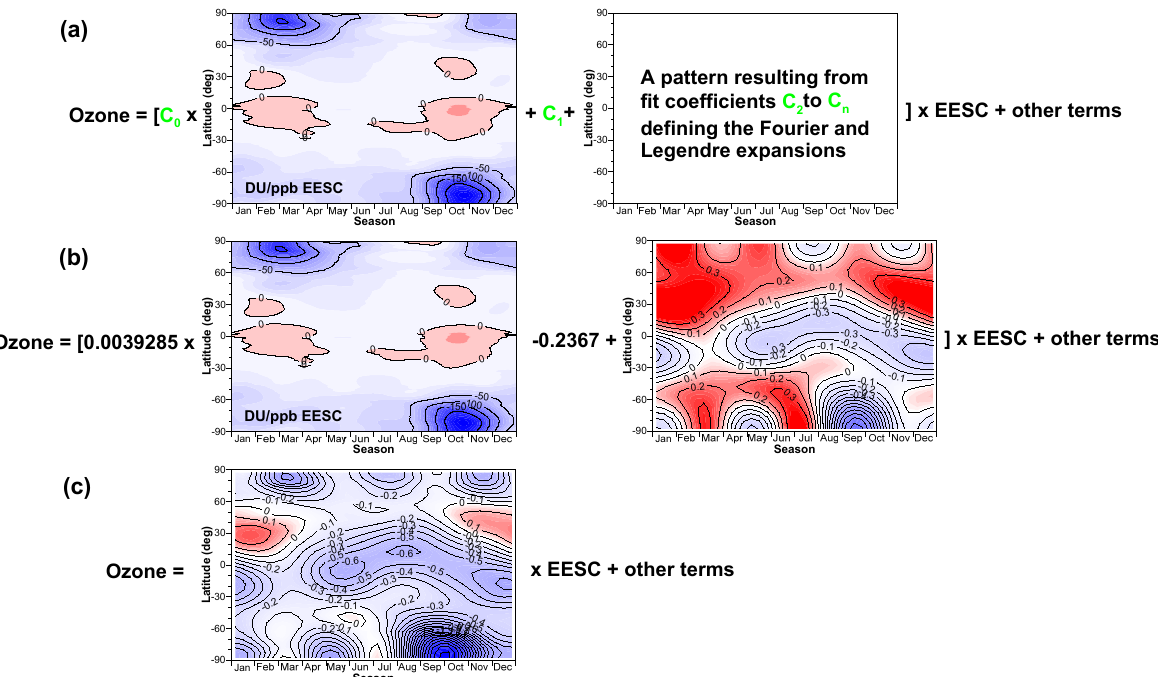
Figure 2. A graphical illustration the derivation of the EESC fit coe ffi cient, which is a function of latitude and season, at 20km. (a) The EESC coe ffi cient is constructed as a first guess pattern response of ozone to EESC plus an o ff set ( C 1 ) plus a perturbation that is constructed from Fourier and Legendre polynomials whose amplitudes are fit coe ffi cients in the linear least squares regression. The first guess pattern response in this case is taken from fit coe ffi cients from a regression model applied to total column ozone data. (b) Shows the situation after the regression model has been fitted to the available ozone data at 20km, while (c) shows the final EESC fit coe ffi cients resolved in latitude and season. Recall that because the regression model includes a trend term, the assignment of variance to the EESC term may be somewhat di ff erent than that expected; the positive (red) regions in (c) are compensated by negative coe ffi cients for the trend coe ffi cient. The pattern shown in (c) then becomes the first guess for the fits at 19km and 21 km.